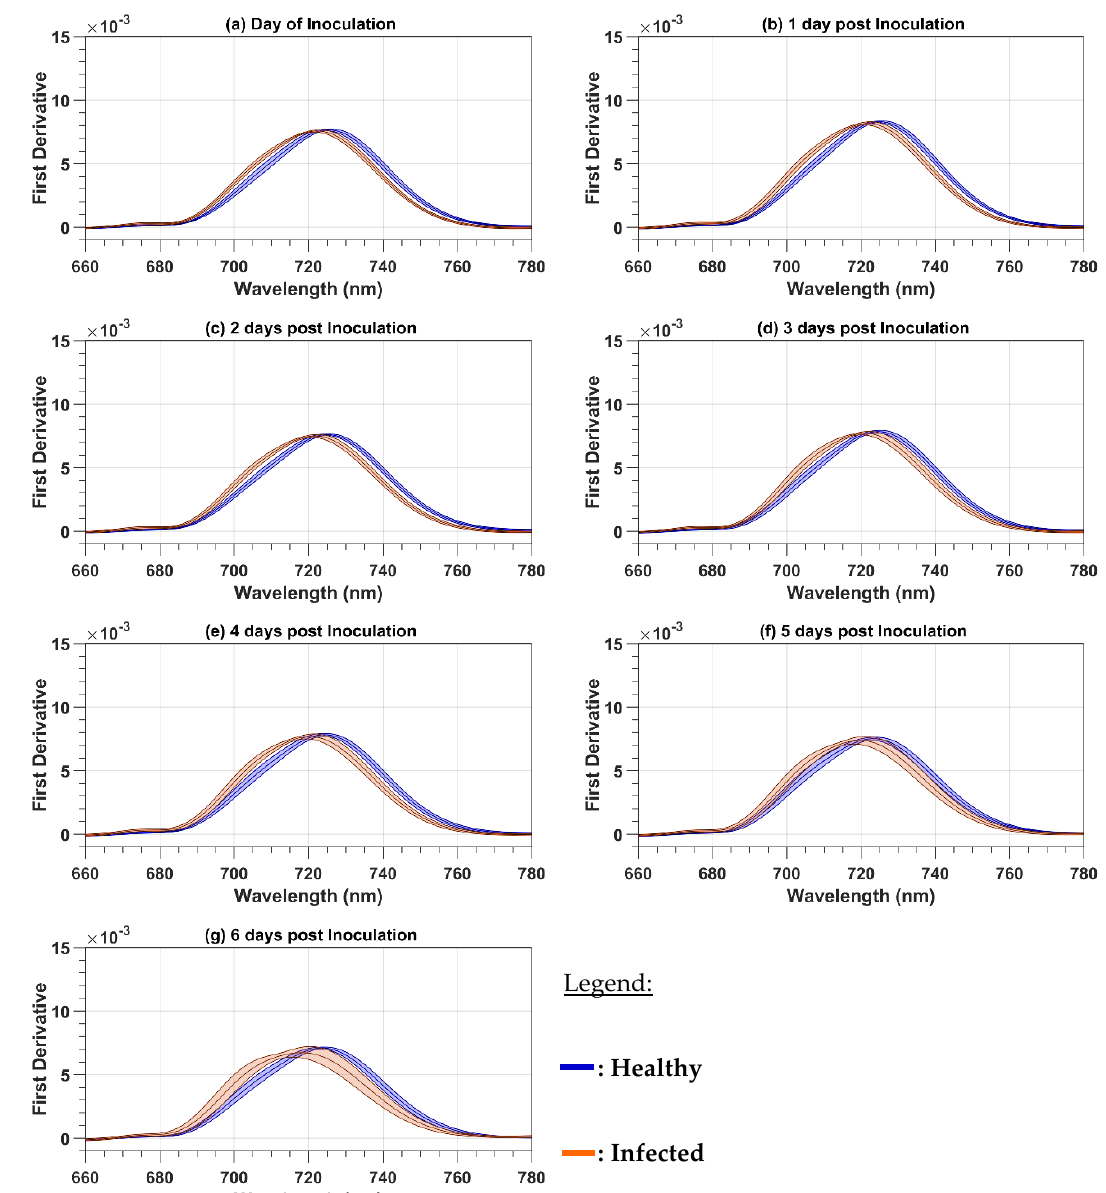
Figure 6. Comparison between healthy and infected plants for the mean first-order derivative reflectance spectra (with one standard deviation) in the red region (660 to 680 nm) and red-edge region (680 to 780 nm) as a function of the number of days post-inoculation ( a – g ).